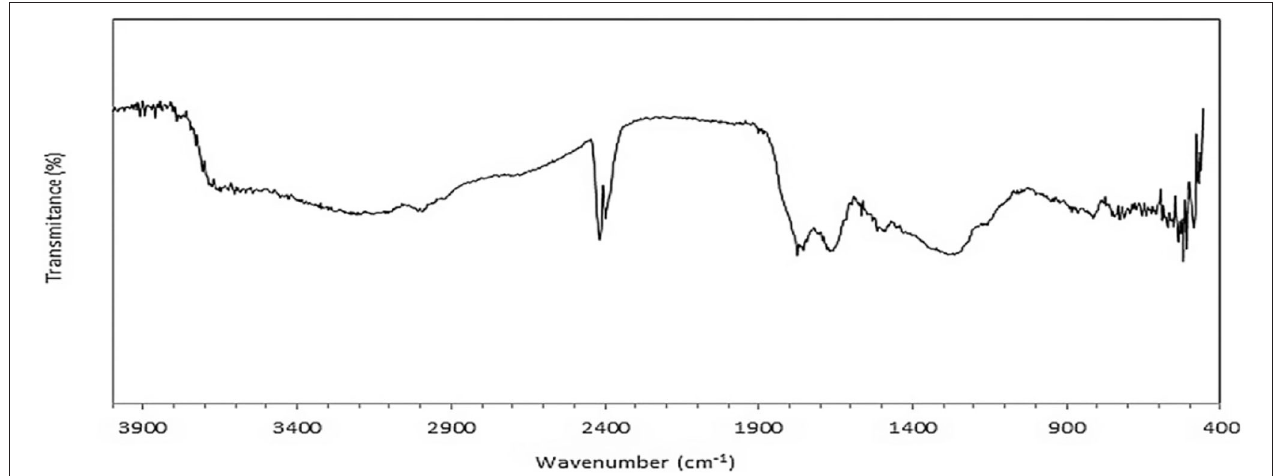
FIGURE 1 | FT-IR spectrum of a typical humic acid (de Souza and Braganc, 2017).